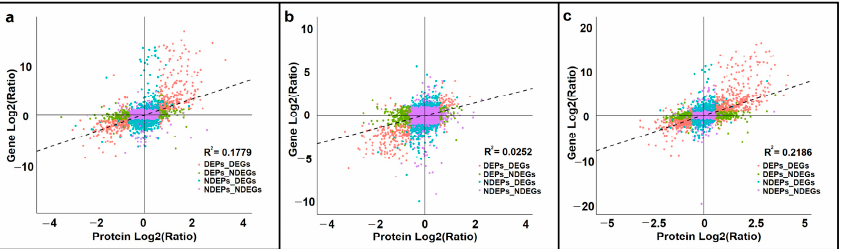
Figure 4. Correlations in the expression levels of proteins and associated transcripts for the ( a ) SEM vs. PEC, ( b ) CE vs. SEM, and ( c ) CE vs. PEC comparison groups. DEPs: differentially expressed proteins; DEGs: differentially expressed genes; NDEPs: no differentially expressed proteins; NDEGs: no differentially expressed genes.